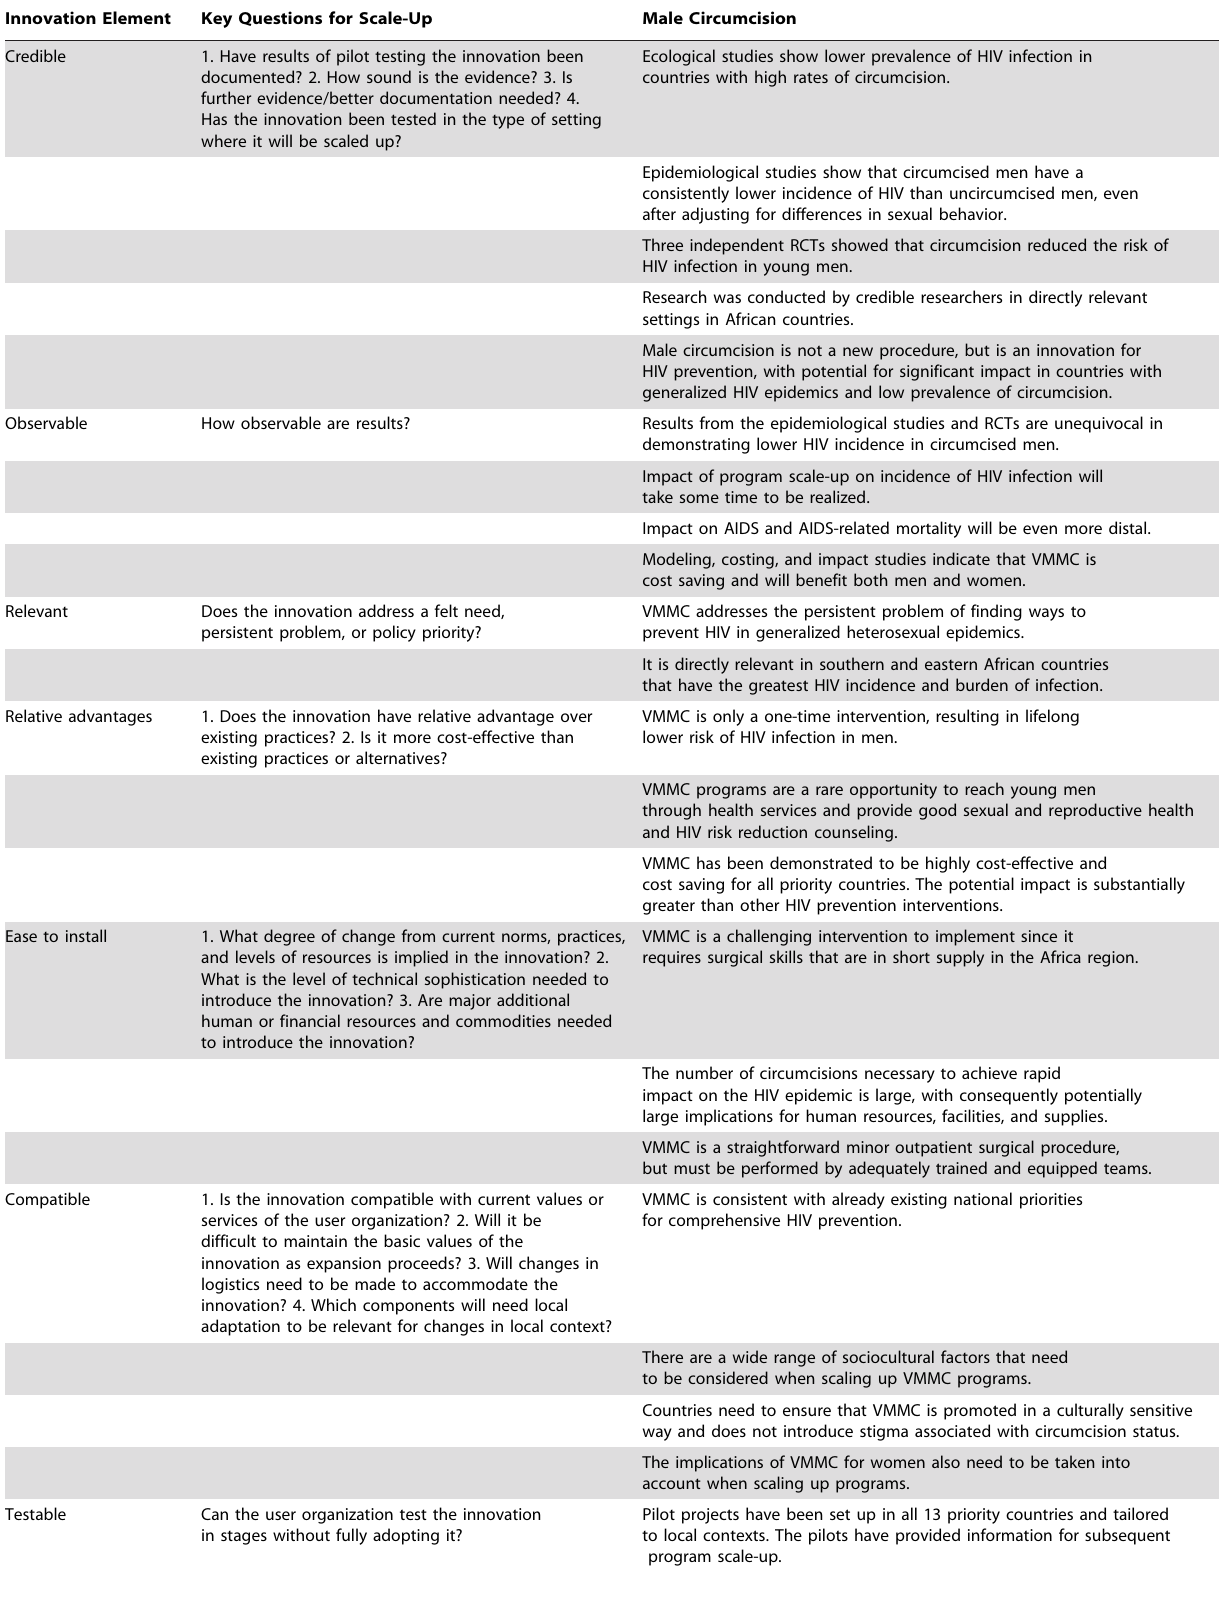
Table 1. ExpandNet innovation